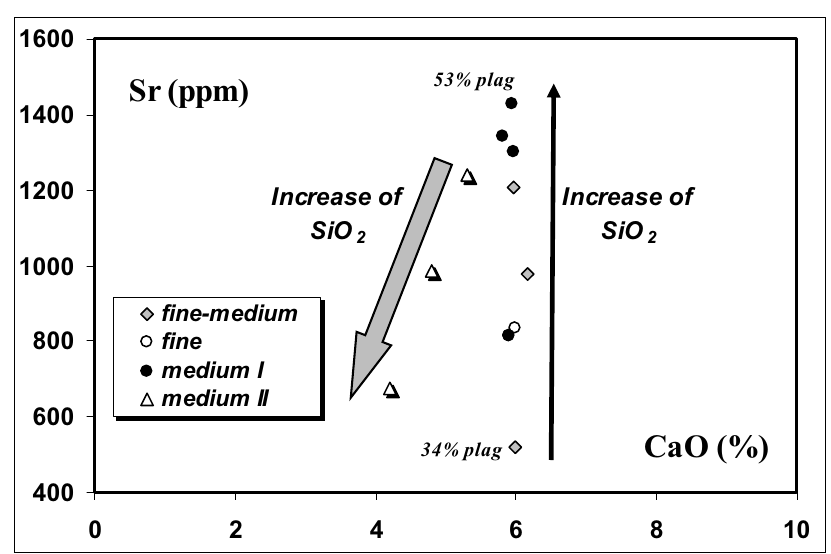
Fig. 3 – Sr × CaO diagram for the recognized facies rocks of the Glória quartz-monzodiorite.